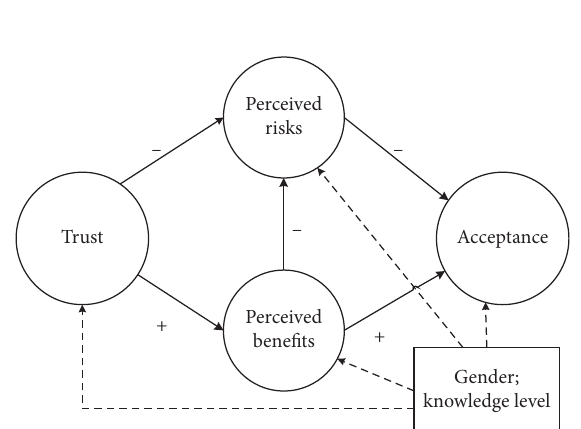
Figure 3: Statistical test model of